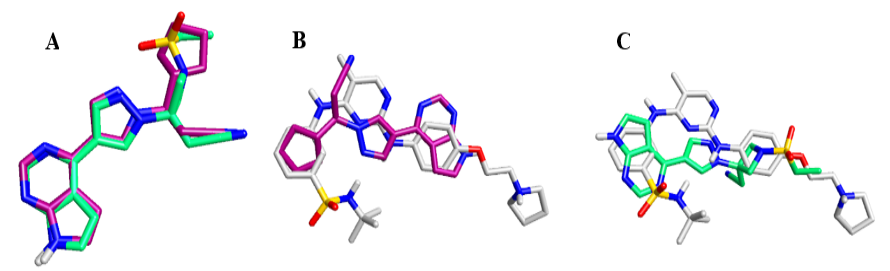
Figure 5. ( A ) An overlay of ruxolitinib (Purple) on baricitinib (Green); electronic similarity percentage = 82.5%. ( B ) An overlay of fedratinib (Gray) on ruxolitinib (Purple); electronic similarity percentage = 54.0%. ( C ) An overlay of fedratinib (Gray) on baricitinib (Green); electronic similarity percentage = 49.1%. Similarity and alignments were measured based on molecular fields descriptors generated by Cresset’s FieldAlign Software (version 1.0.2), [37].